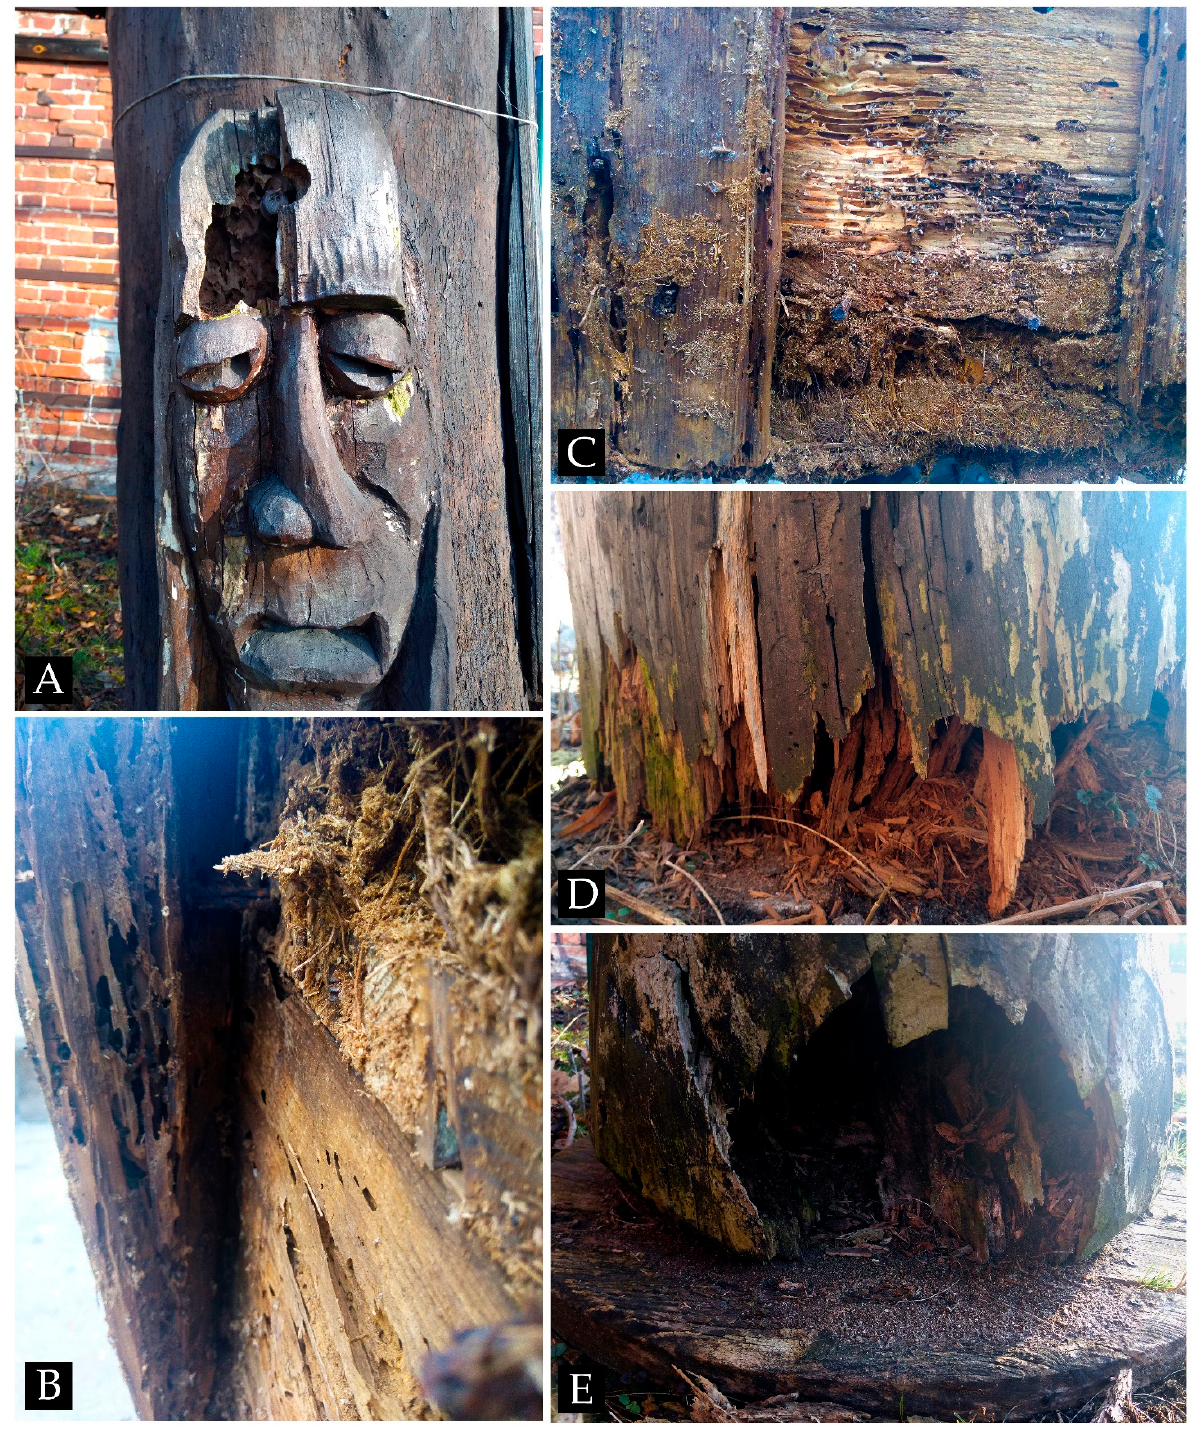
Figure 3. Damage on wooden objects exposed in the open air (( A – E ): artefacts from the collection of The Museum of Apiculture in Swarz˛edz, a branch of The National Museum of Agriculture and Food Industry in Szreniawa, Poland).